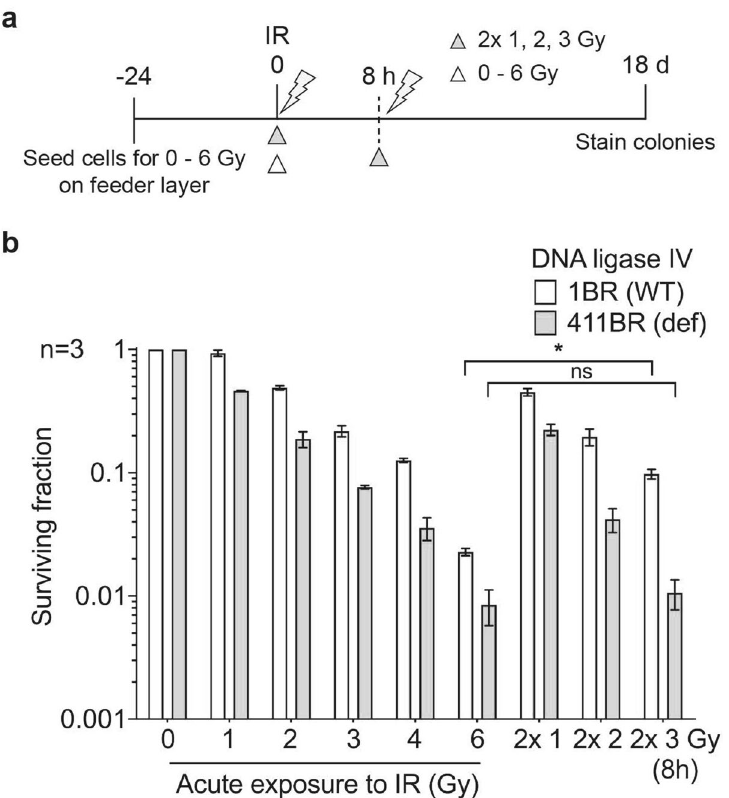
Figure 3. Reduced split-dose recovery is observed in NHEJ defective fibroblast cells. 1BR hTERT and 411BR hTERT fibroblast cells were exposed to either acute or split-dose IR with indicated doses ( a ) schema (white triangle, single acute dose and grey triangle represents split-dose radiation) ( b ) colony survival assay confirming loss of split-dose recovery in 411BR hTERT. ‘*’ indicating statistical significance between acute 6 Gy vs 2 × 3 Gy in 1BR hTERT